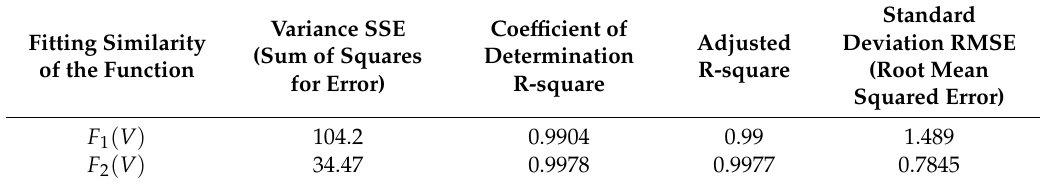
Table 2. The fitting similarity of hysteresis curves.